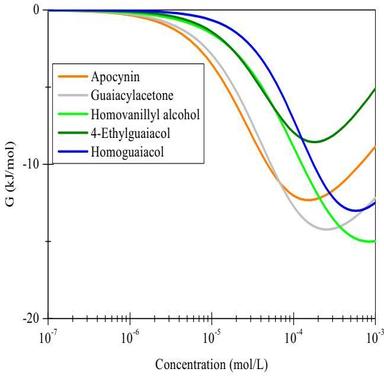
Evolution of the free Gibbs enthalpy versus the concentration for the five studied systems.